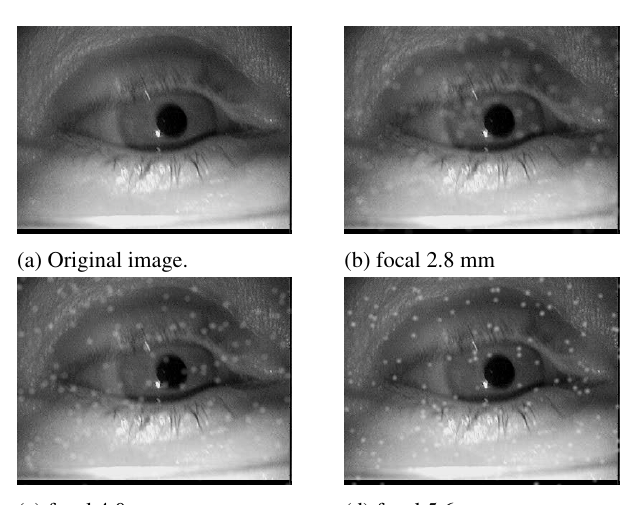
Figure 5 . Simulation results for di ff erent focal lengths on one image. 200 particle of size group 2 were